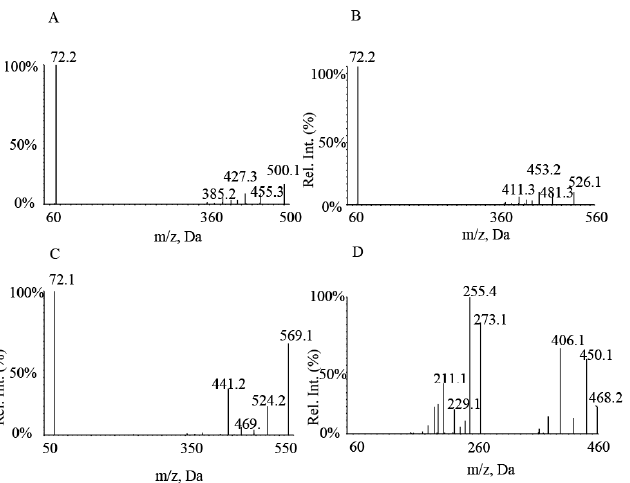
Figure 2. Product ion spectra of (A) osimertinib, (B) aumolertinib, (C) furmonertinib, and (D) IS.